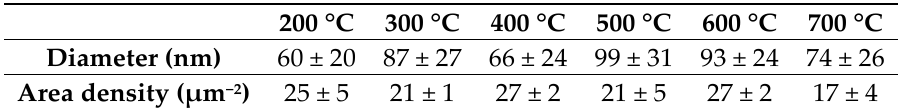
Table 1. Summary of the characterized parameters of NRs grown at different pre-annealing